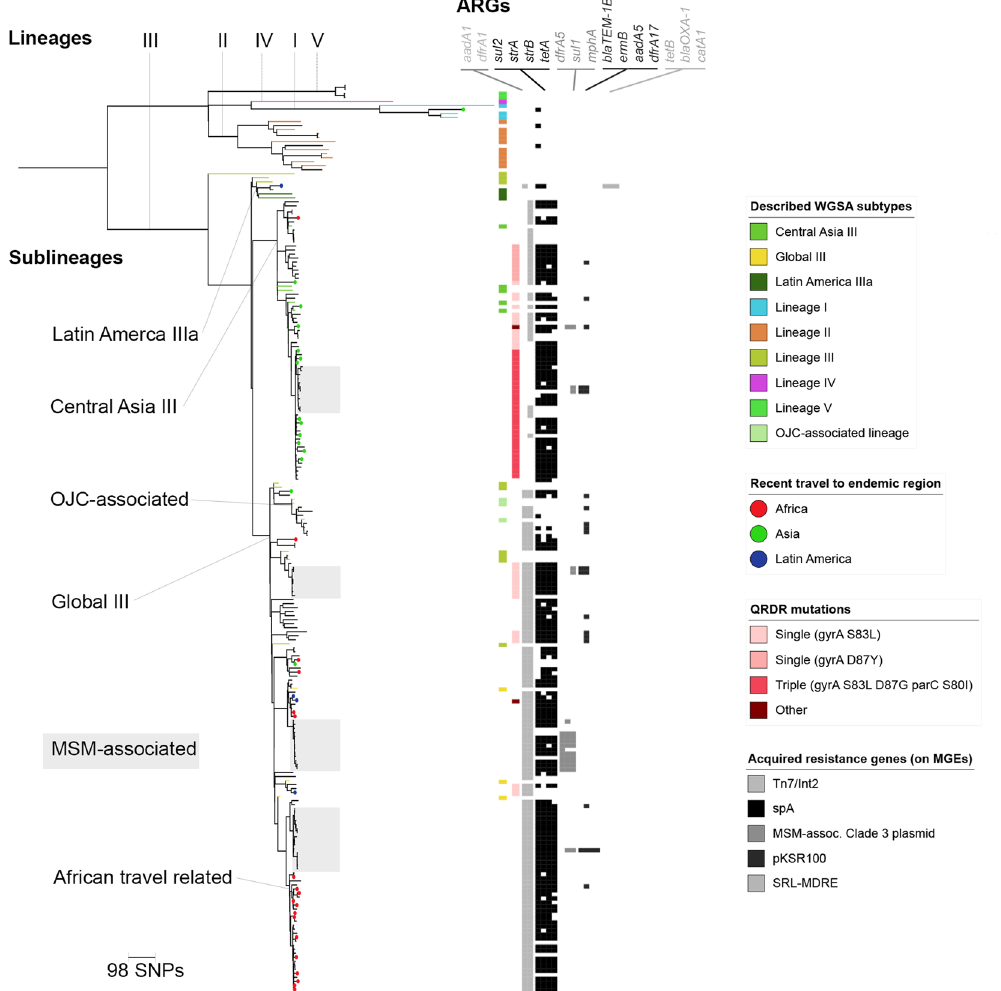
Figure 3. Shigella sonnei UK cross section in context. The midpoint-rooted maximum likelihood phylogenetic tree shows isolates from this study in the context of five global lineages of S . sonnei . Lineage III has further relevant sublineages indicated at the internal nodes and MSM-associated sublineages are highlighted in grey. Isolates from patients recently returned from endemic regions are indicated by circles overlying the tree tips which are coloured according to the inlaid key. Reference isolates from previously described WGSA subtypes (lineages/sublineages) are indicated in the leftmost adjacent track, and tree branches for references isolates are also coloured according to the inlaid key. AMR features are shown in subsequent tracks. The second leftmost track shows the presence of QRDR mutations and two isolates containing ‘Other’ quinolone resistance determinants (including an isolate with a single QRDR mutation and a qepA gene, and an isolate containing a qnrB19 gene). Subsequent gray scale tracks indicate the presence of antimicrobial resistance genes (ARGs, labelled above) associated with known Shigella MGEs. Specifically (from left to right), the Tn7/Int2, SpA, MSM- associated sublineage 3 plasmid, pKSR100, SRL-MDRE (Table